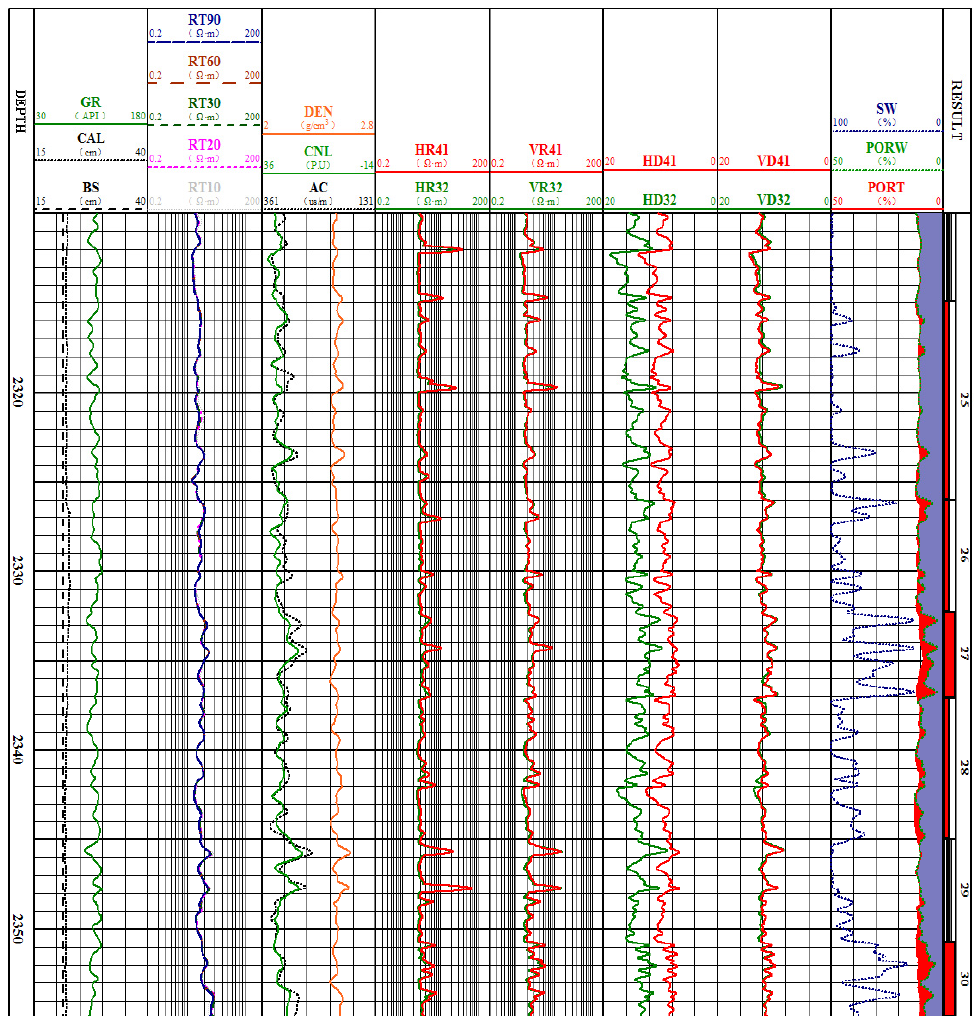
Figure 15. The dielectric logging sensor using the proposed antenna applied in the oilfield. The fifth column shows the HR41 and HR32 curves; these are the resistivity values (in the horizontal polarization direction of the formation) provided by the broadside an- tennas of the dielectric logging sensor. The sixth column shows the VR41 and VR32 curves; these are the resistivity values (in the horizontal polarization direction of the for- mation) provided by the end-fire antennas of the dielectric logging sensor. The seventh channel shows the HD41 and HD32 curves; these are the dielectric values in the formation horizontal polarization direction provided by broadside antennas of the dielectric sensor. The eighth channel shows the VD41 and VD32 curves; these are the dielectric values (in the vertical polarization direction of the formation) provided by the end-fire antennas of the dielectric logging sensor. In the ninth channel, PORT is the total formation porosity (red solid line) determined from the intersection of the neutron density in the fourth